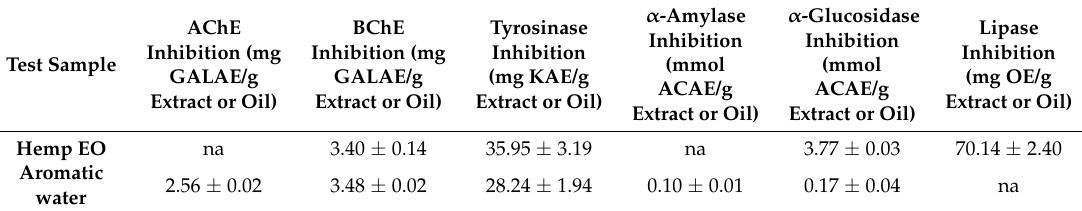
Table 9. Enzyme inhibitory effects * of the C. sativa samples.